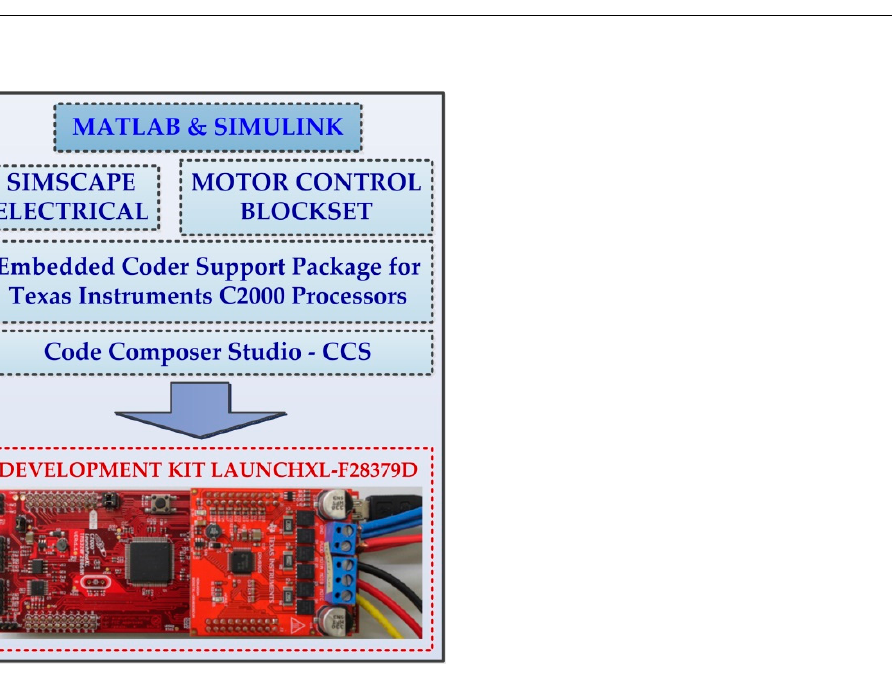
Figure 24. Development and testing architecture for the control of the PMSM application—PIL stage.